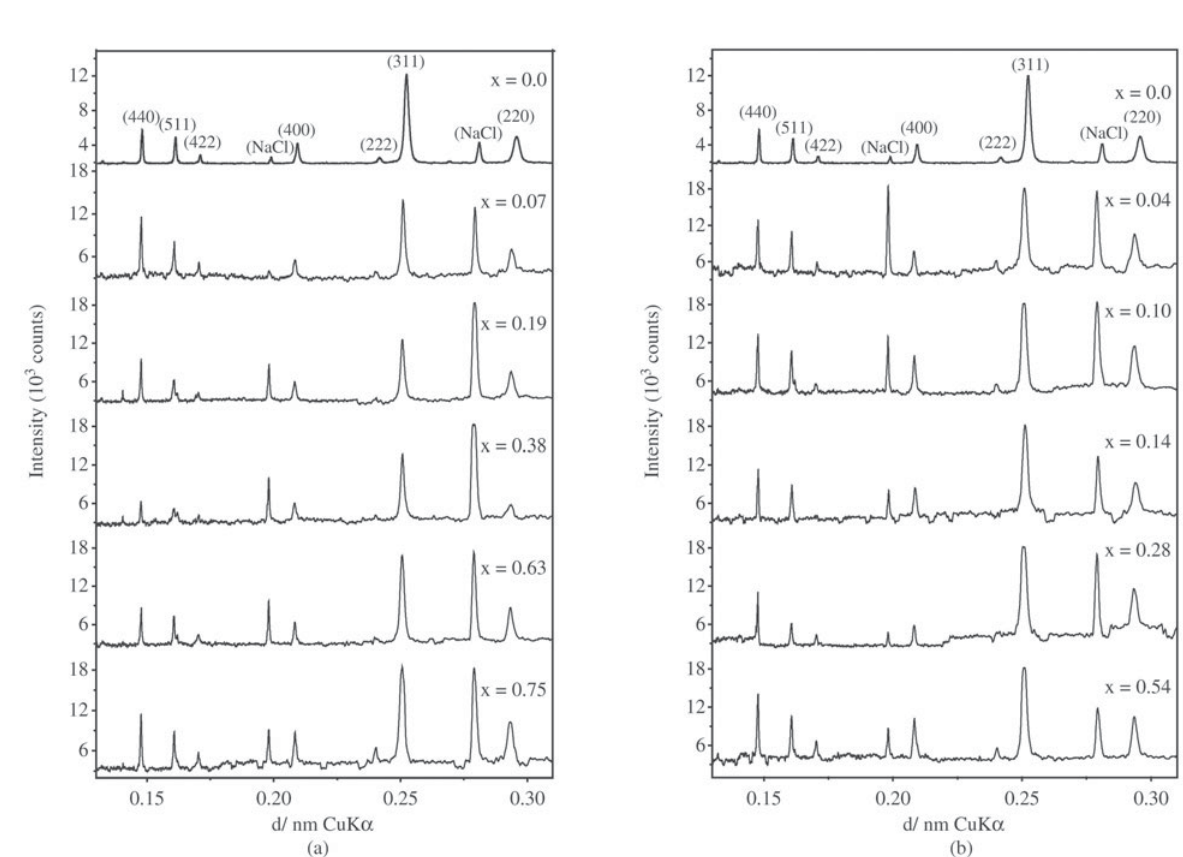
Figure 2. Powder X-ray patterns for the (a) Fe